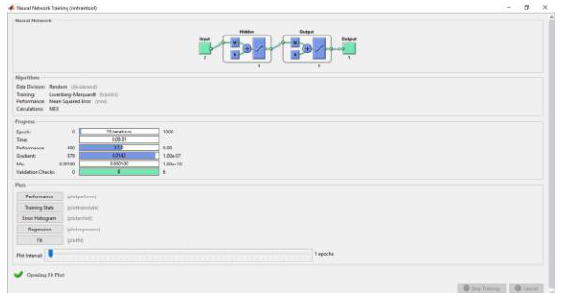
Figure 4 . Complete neural network of project